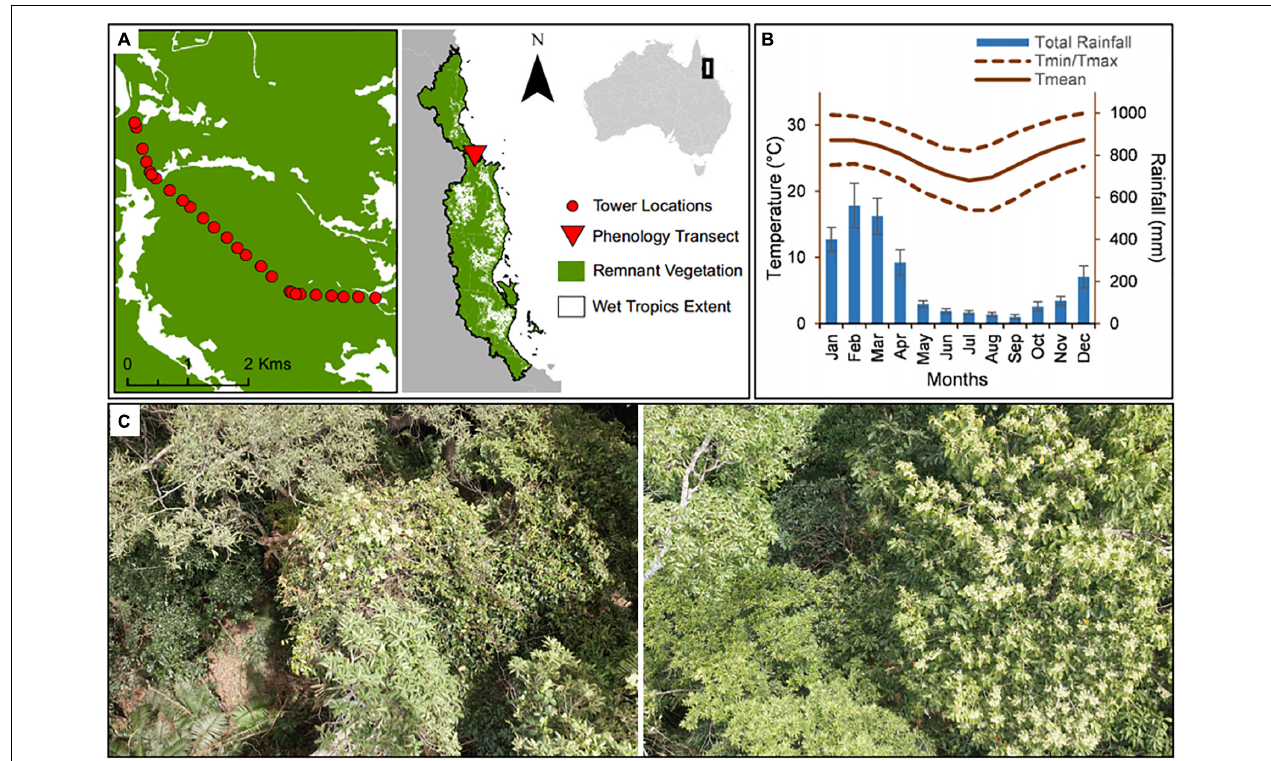
FIGURE 1 | Location and mean annual climate for the study region. (A) Wet Tropics World Heritage Area extent with phenology transect located in Barron Gorge National Park, Far North Queensland, Australia. (B) Monthly general meteorological patterns of rainfall (mm), maximum temperature (Tmax ◦ C), minimum temperature (Tmin ◦ C), and mean temperature (Tmean ◦ C) from January 2000 to December 2014, and (C) View from the forest canopy as seen from the